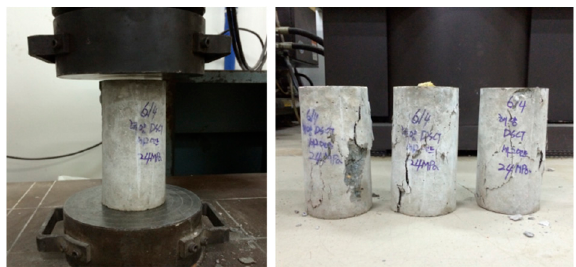
Figure 16. Tested concrete molds. Table 2. 28-day compressive strength of concrete. Specimen No.